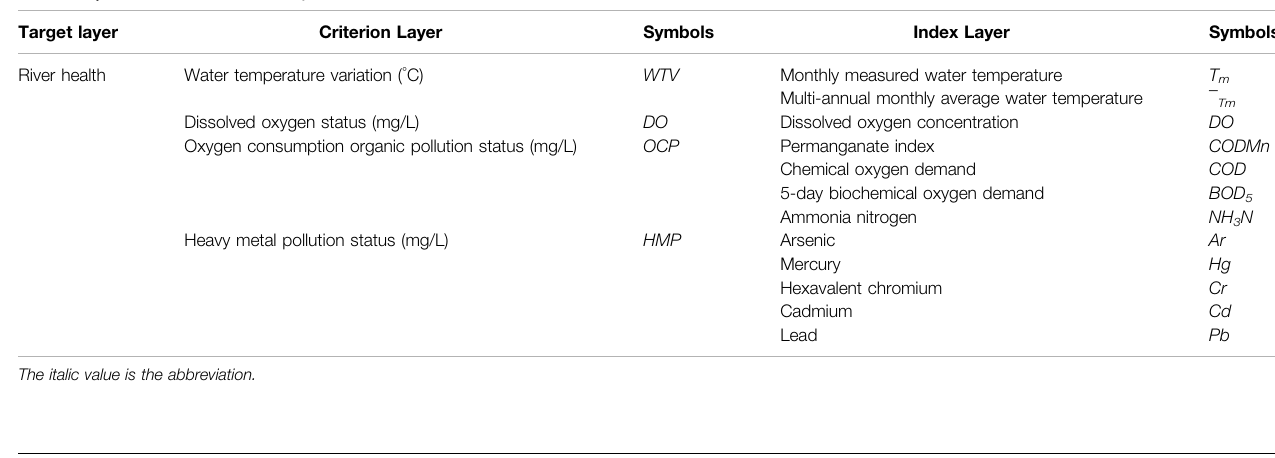
TABLE 1 | River health assessment system indices.